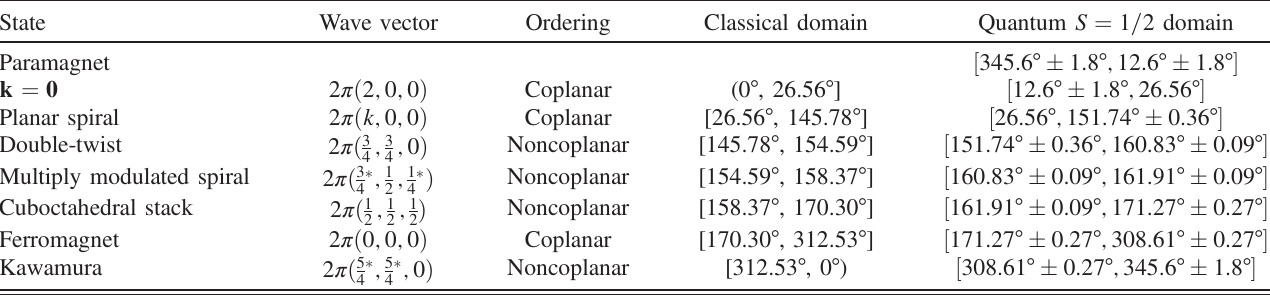
TABLE I. Classical magnetic long-range ordered phases stabilized in the J 1 - J 2 Heisenberg model. The ordering is labeled as coplanar if there exists a subset of states which are coplanar. The wave-vector components marked by an asterisk have slight incommensurate deviations within the phase away from the given rational values [see the text for